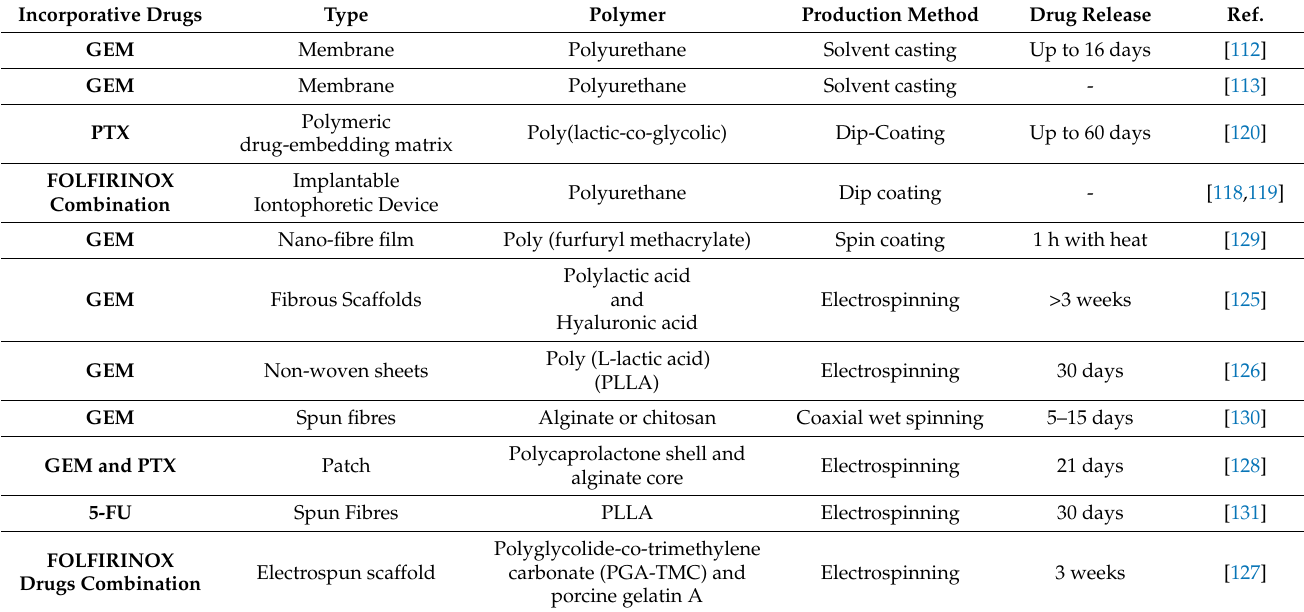
Table 3. Implantable DDSs for localised delivery to pancreatic tumours from